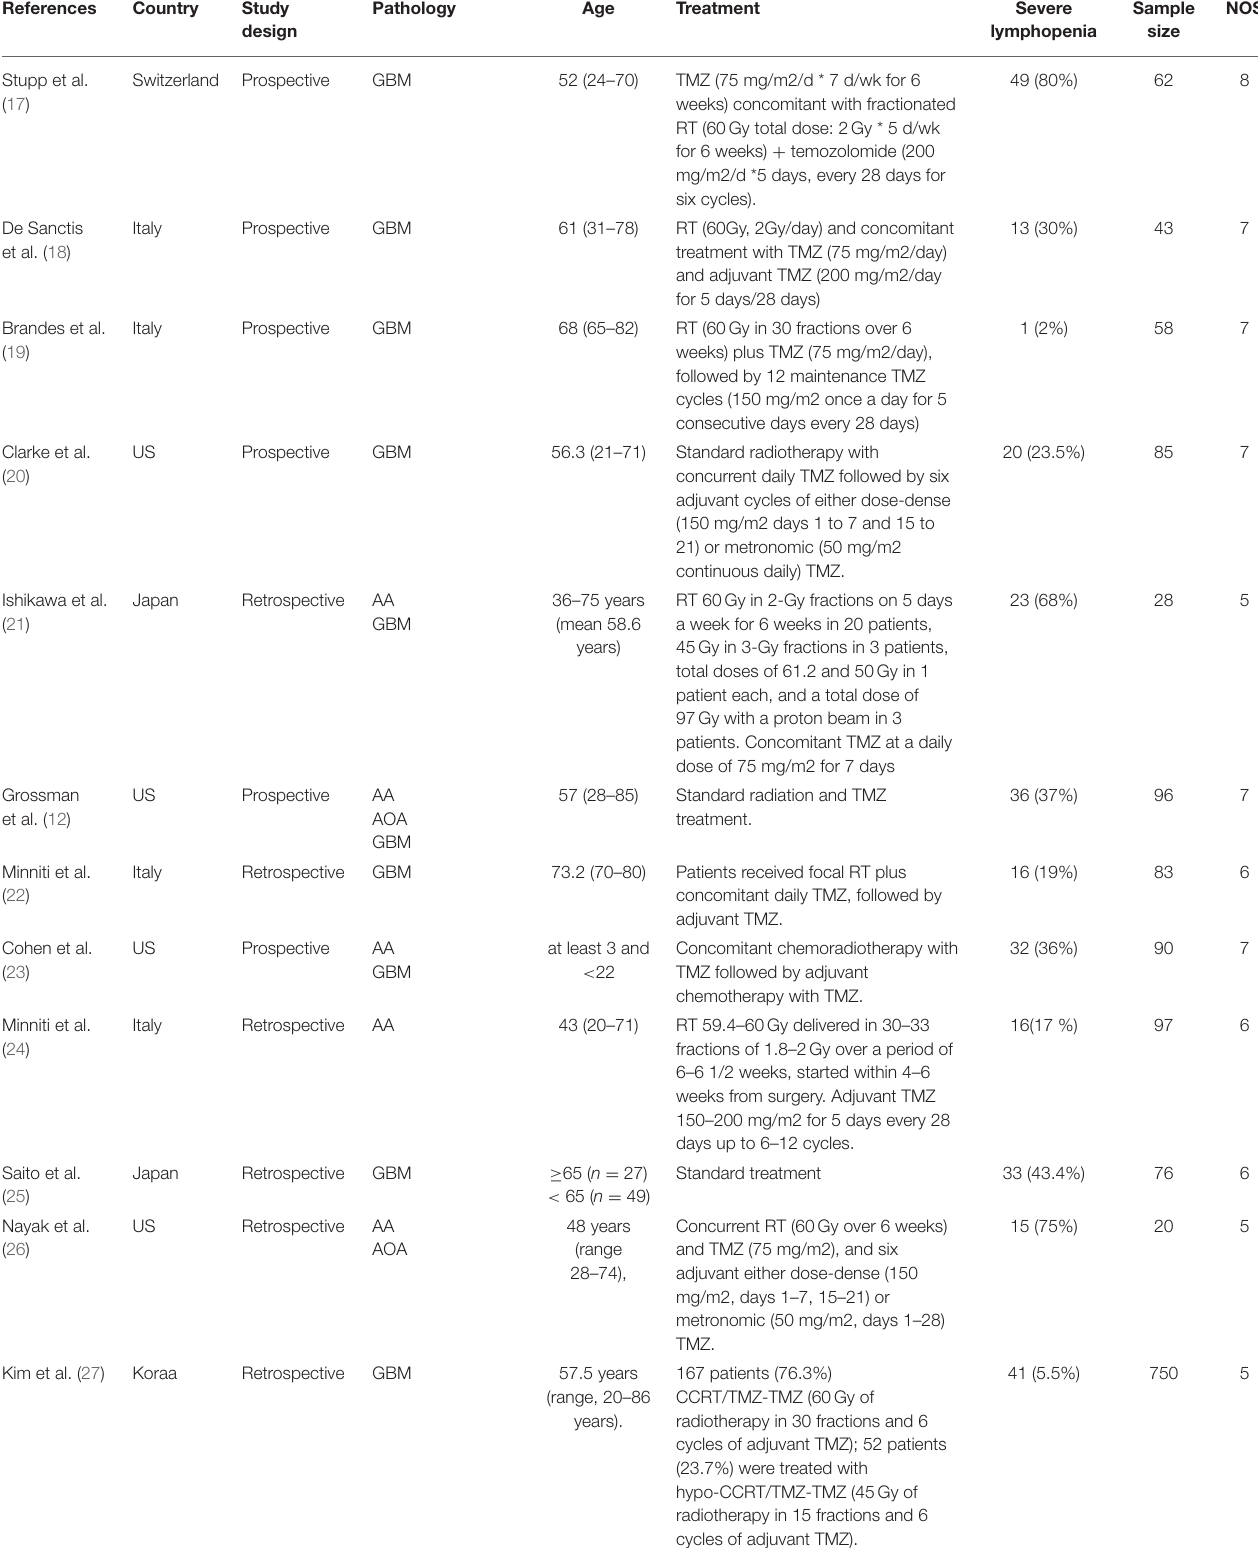
TABLE 1 | The main characteristics of studies included in this meta-analysis for